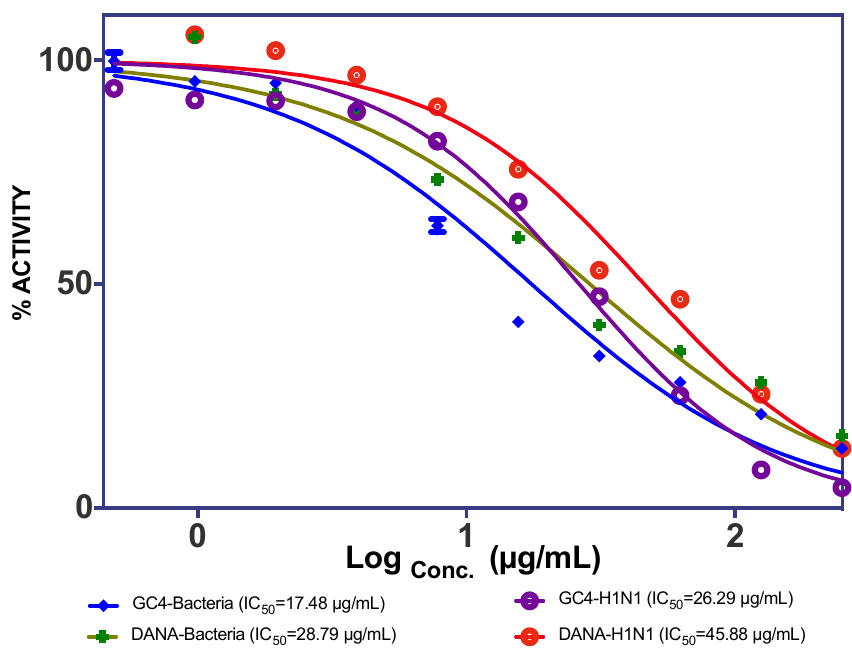
Figure 5. NA inhibition of isolated compound catechin as compared to DANA, as a gold standard against C. Perfringens -NA (blue) and H 1 N 1 -NA (purple).